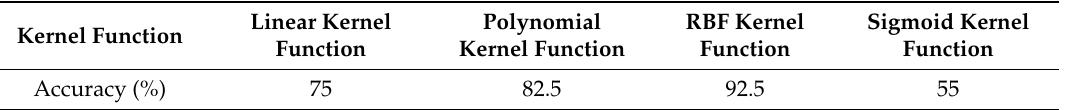
Table 5. The prediction accuracy comparison using different support vector machine (SVM) kernel functions.